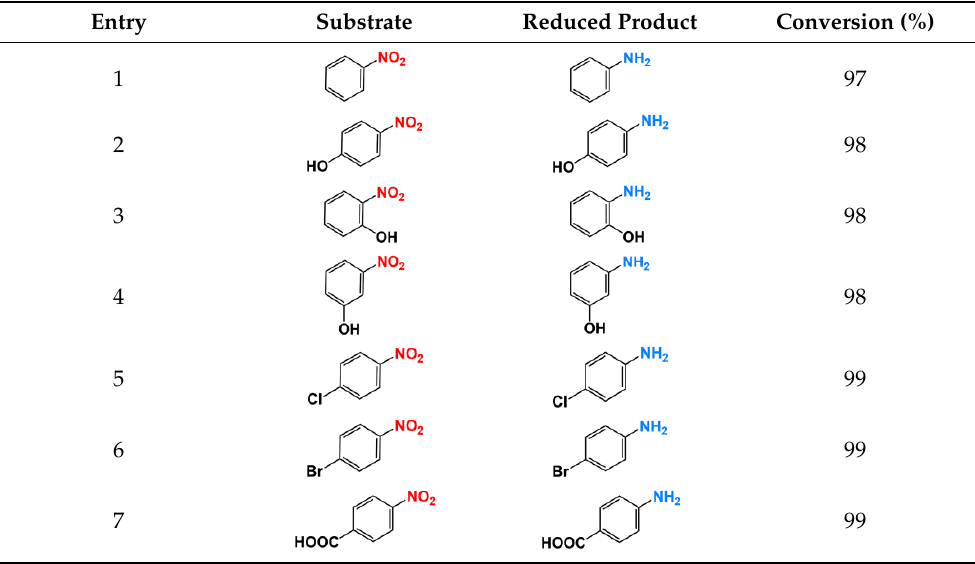
Table 1. HPLC determined composition of the reaction solutions before and after the gCN-FePc-1 photocatalysis.